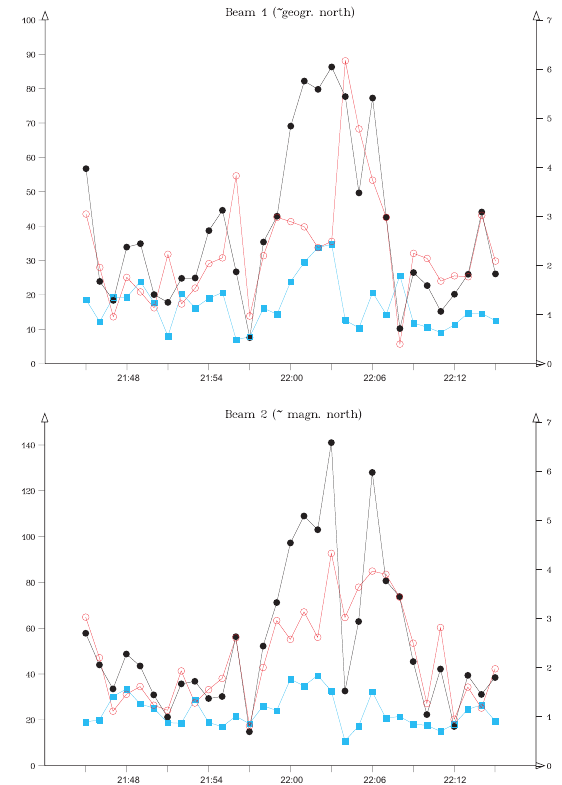
Fig. 9. The height-integrated conductances with time obtained from EISCAT radar for two VHF beams from the Tromso radar: Beam 1 looks (almost) to the geographic north, beam 2 (almost) to geomag- netic north. Black points are 6 H , blue quadrants 6 P (scale to the left), and red circles α = 6 H /6 P (scale to the